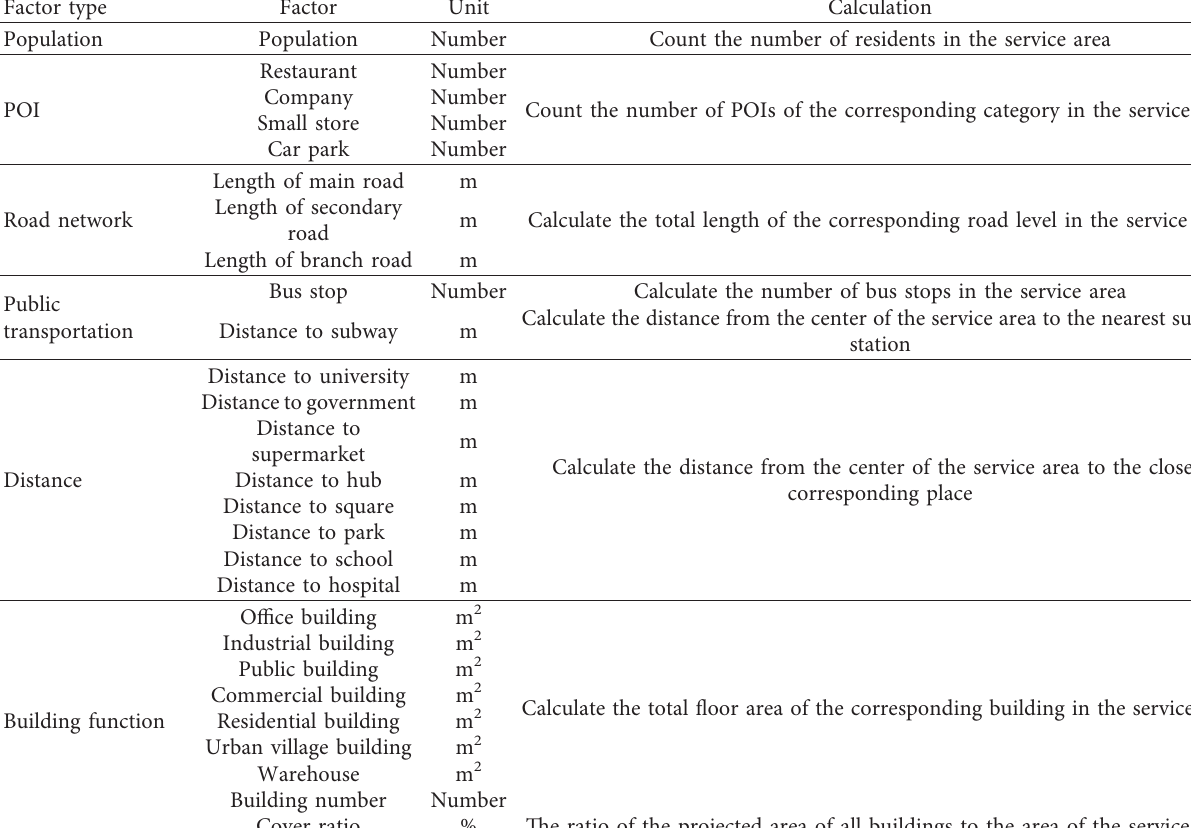
Table 1: The influencing factors of bike